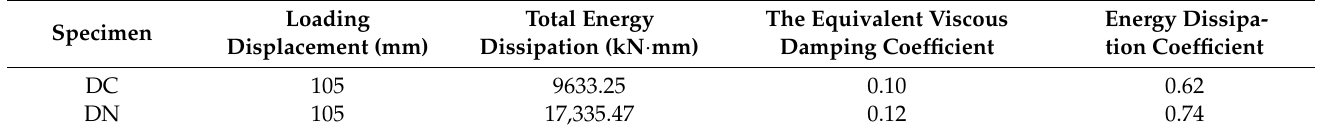
Table 5. Parameters of energy dissipation.